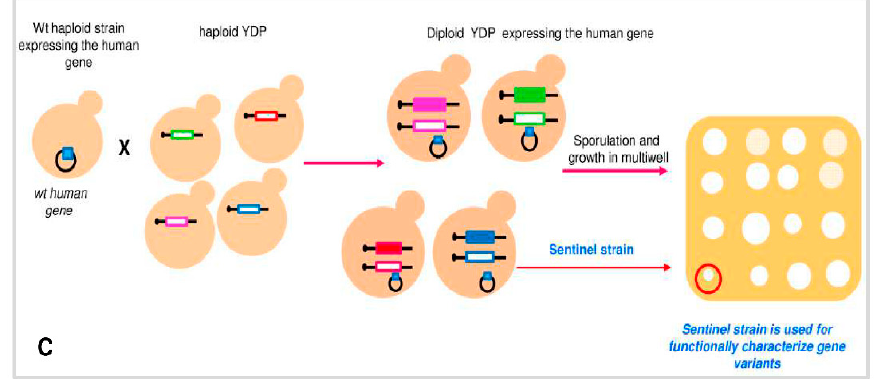
Figure 1. Schematic representation of high throughput approach. ( A ) The wild type (wt) human genes associated with a disease, with an essential yeast ortholog/paralog, have been expressed in yeast temperature sensitivity (ts) mutant strains and grown at restrictive temperature to test their ability to rescue the ts phenotype. After the identification of the complementation pair, missense variants of the selected human gene were assayed. ( B ) Large scale study for the functional characterization of variants of human chromosome instability (CIN) genes. Diploid query strain : Strain carrying the plasmid for the overexpression of the human gene and heterozygosis for a CIN gene. Sporulation of a query strain produces haploid yeast strains expressing a human CIN. Growth will be observed in strains expressing a human CIN complementing the yeast mutant. Gene variants were expressed in the identified strain and grown in the presence of DNA damaging agents for the classification. ( C ) sentinel interaction mapping (SIM) approach. The wt haploid strains expressing the human gene are crossed with haploid yeast deletion pool (YDP) strains. Sporulation of the resulting diploid strains produces haploid strains. Those showing growth defects in the presence of the human gene are the sentinel strains that were used to classify the gene